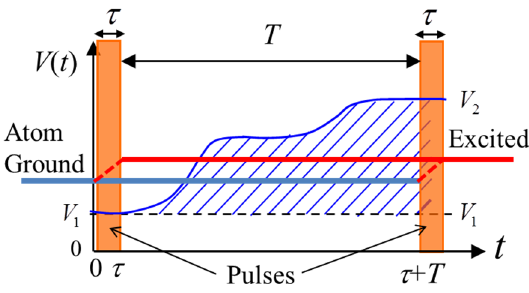
Figure 1. Ramsey atom interferometer under time-varying potential V ( t ).